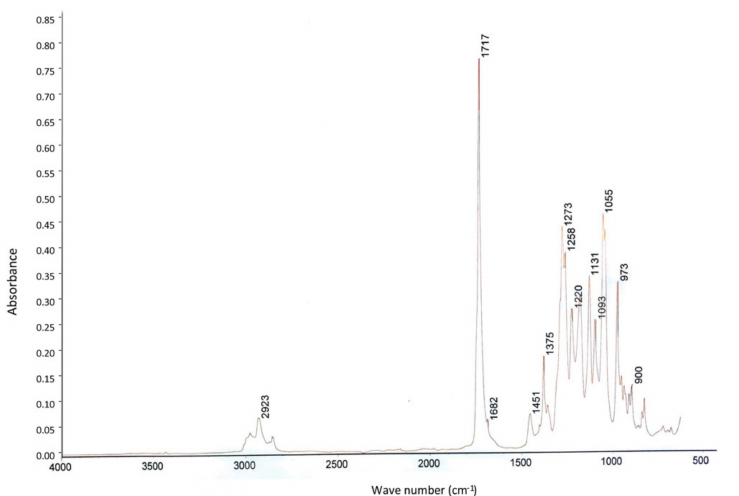
Figure 3. FTIR spectrum of PHAs produced by HW T5.17 T strain ( Acidisoma cellulosilytica ) grown on TSB depleted in nitrogen and supplemented with glucose as sole carbon source (a similar spectrum was obtained with strain HW T2.11 T